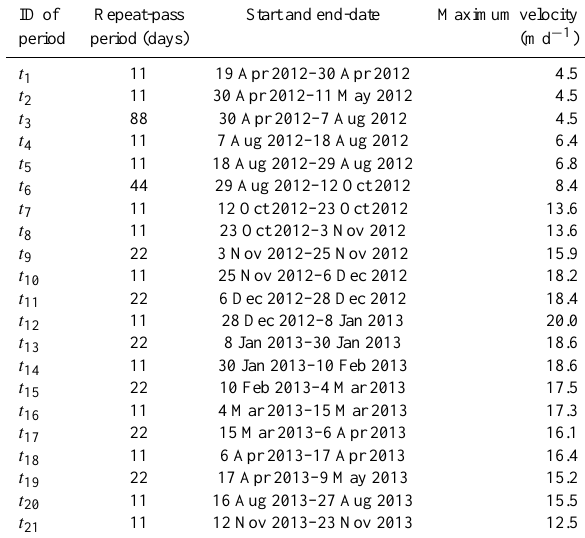
Table A1. TerraSAR-X acquisitions of Basin-3 and repeat-pass pe- riod and maximum velocities of inferred velocity